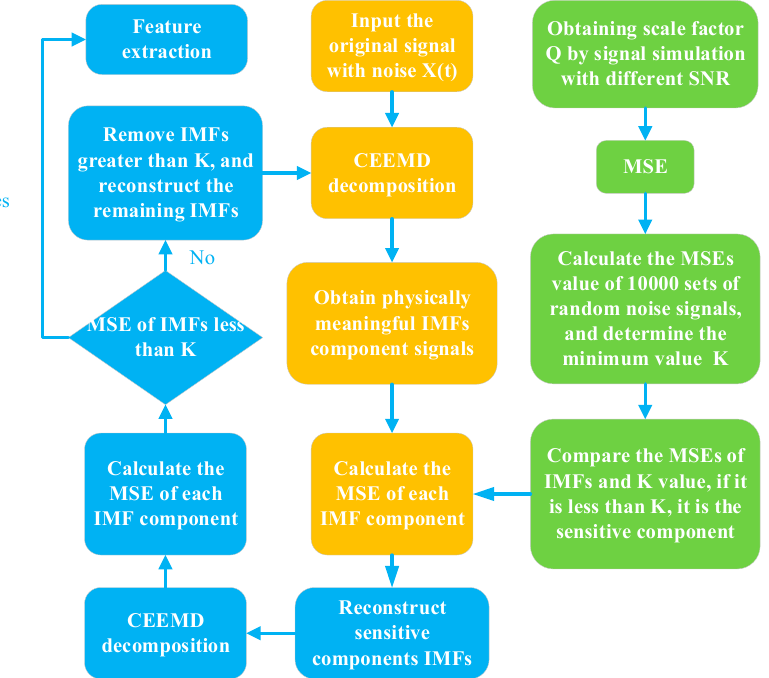
Figure 3. Optimized CEEMD method flow chart.